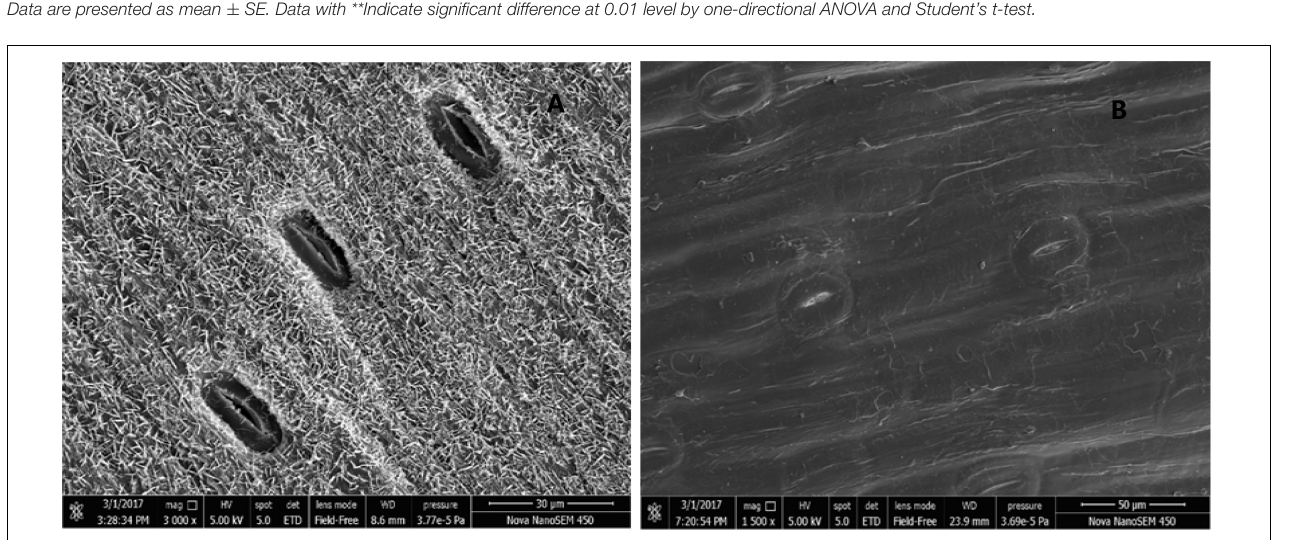
FIGURE 5 | Cryo-scanning electron micrographs of stomata. (A) Diploid garlic. (B) Tetraploid garlic.